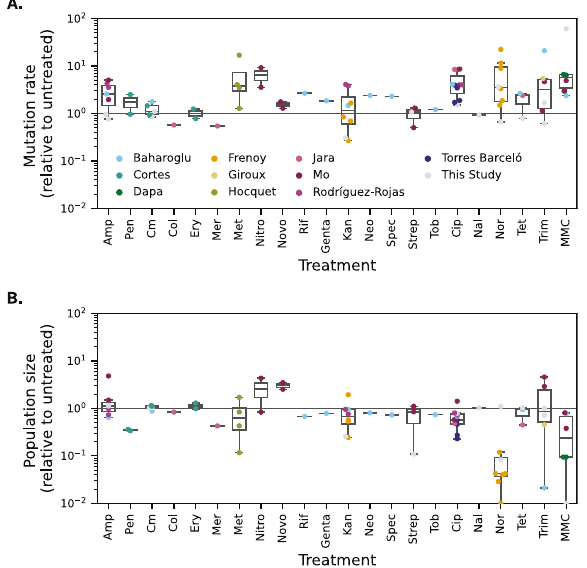
Fig. 2 Effect of antibiotic treatments on estimated mutation rate and population size. Different antibiotics are shown in different columns on the x axis, ordered by class. Colours indicate different studies (ten datasets from the literature plus our data). A single study may comprise several data points associated with the same antibiotic because several doses were tested or because several biological replicates (each of them comprising several parallel replicate populations) were performed. A Effect of antibiotic treatments on estimated mutation rate, under the assumption that there is no cell death. All mutation rates are relative to the untreated control (rel. NT, horizontal line y = 1). The mutation rates were estimated using rSalvador [29]. B Effect of antibiotic treatments on population size. All population sizes are relative to the untreated control (horizontal line y = 1). Each data point represents the